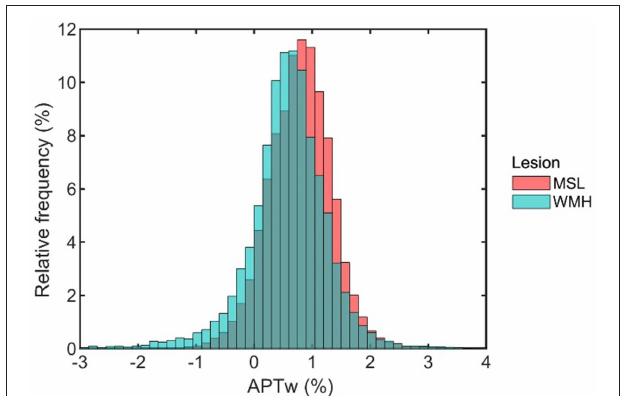
FIGURE 4 | Histogram profiles encompassing all voxels obtained from MS lesions (MSL) and white matter hyperintensities of presumed vascular origin (WMH).